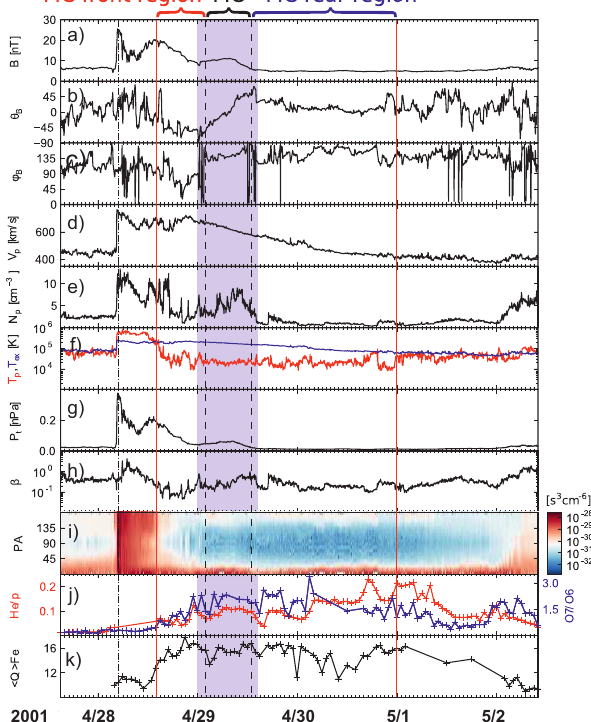
Fig. 7. Example of the event on 28 April–1 May 2001. Panels are same as in Fig. 2. The pair of red lines bound the ICME interval and the pair of black, dashed lines the MC interval. The dash-dotted line indicates the interplanetary shock, and the highlighted region the interval of the unperturbed flux rope from the Grad–Shafranov